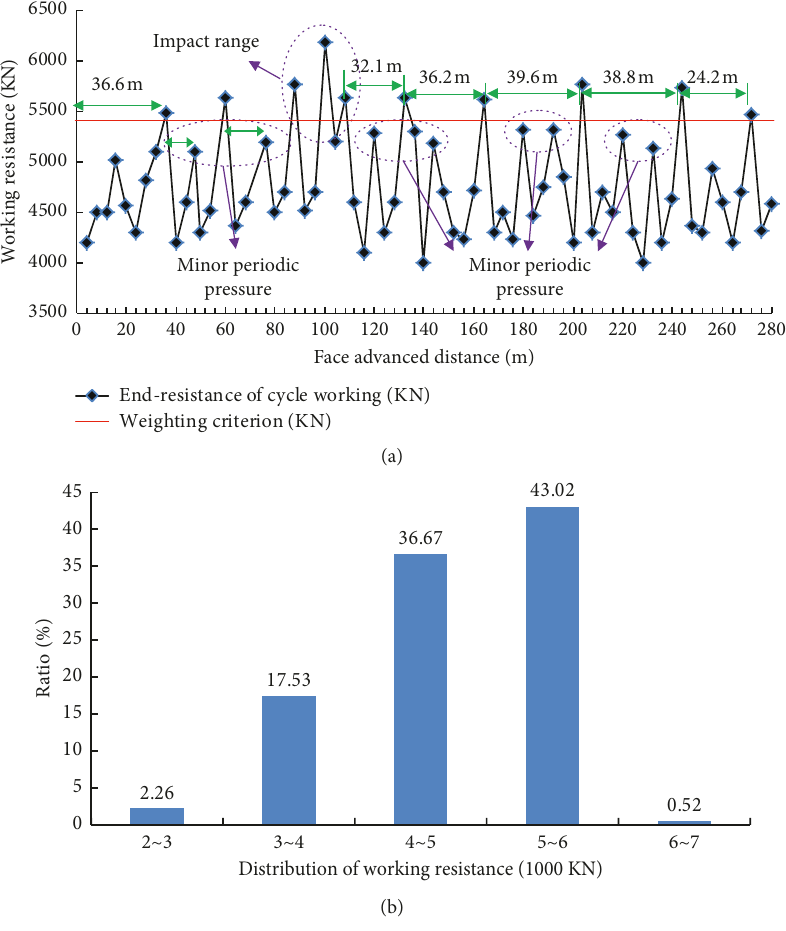
Figure 18: Strata behavior characteristics of the working face. (a) Hard roof caving characteristic and (b) interval distribution of supports